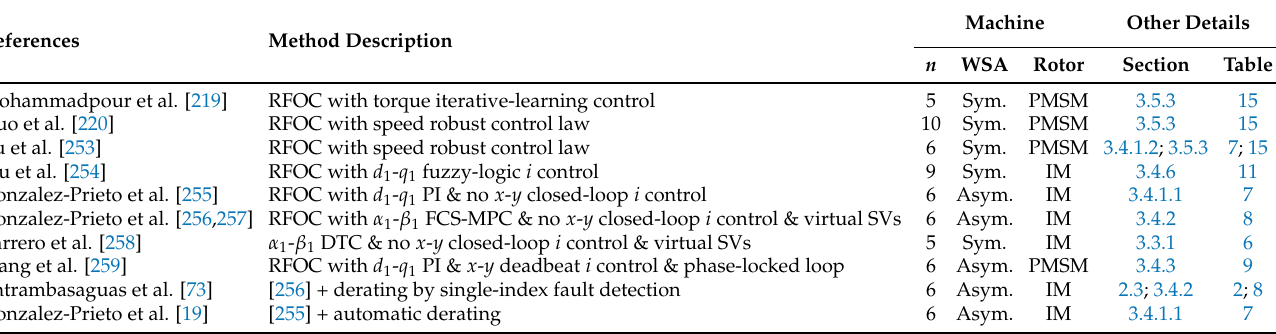
Table 16. Reconfigurationless control methods for tolerating phase OCs (Section 3.6) in multiphase applications in the